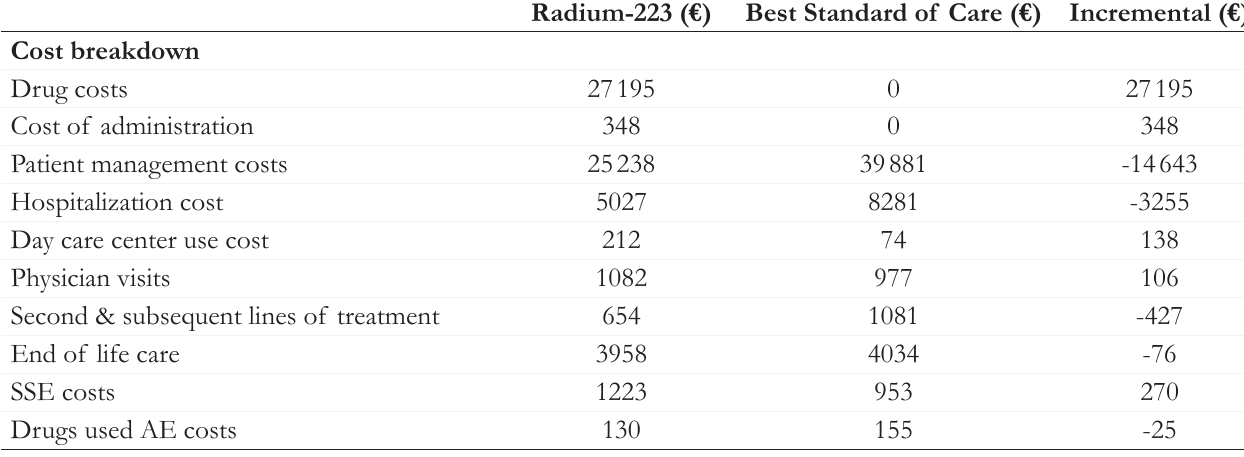
Table 5. Cost Breakdown Base-case Results